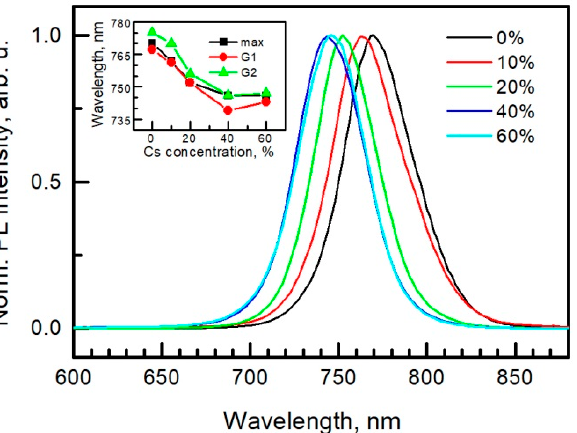
Figure 7. PL spectra of perovskite layers with different cesium concentration. The inset shows position of the PL peak maximum and two Gaussian peaks versus Cs concentration.